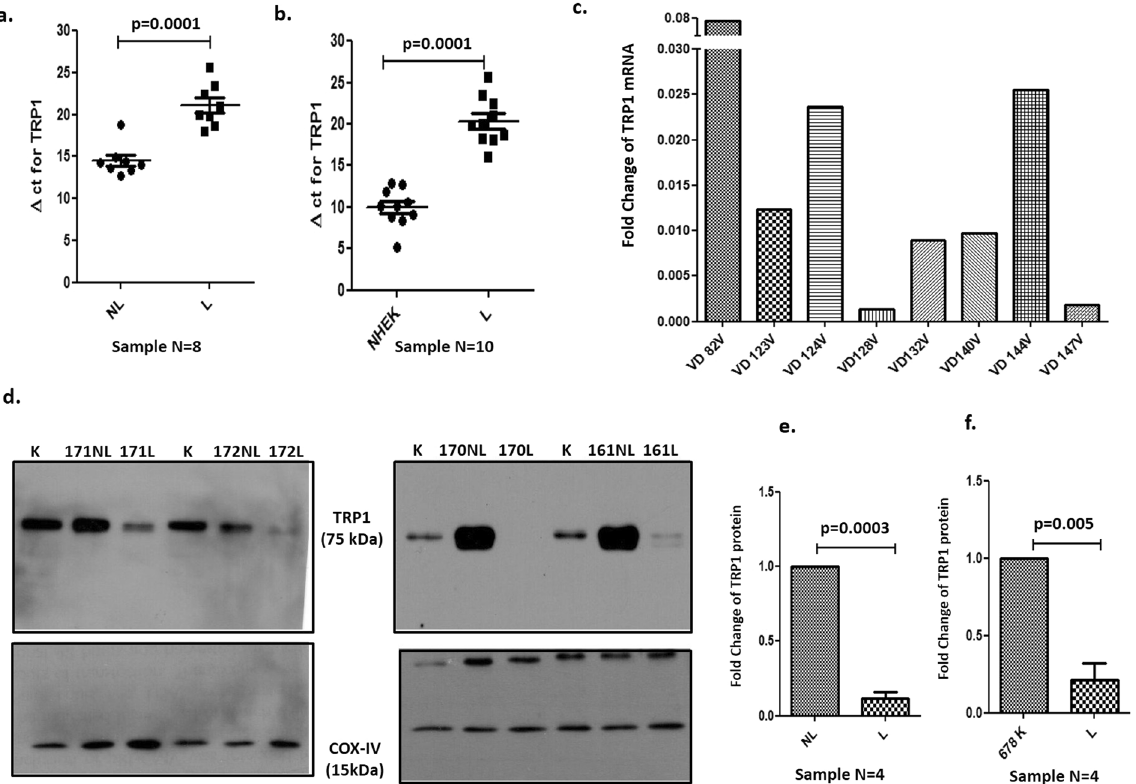
Figure 5. Expression of TRP1 in lesional (L), non-lesional (NL) epidermis and Normal human epidermal keratinocytes (NHEK). ( a ) Transcriptional expression of TRP1 shown as Δ CT in non-lesional and lesional epidermis from vitiligo patients. (n = 8) ( b ) Transcriptional expression of TRP1 shown as Δ CT in NHEK (n = 10) and lesional epidermis (n = 10) from vitiligo patients, ( c ) Downregulation of TRP1 expression in terms of fold change in lesional epidermis compared with non-lesional epidermis in 8 Vitiligo patients samples (VD). ( d ) Western blot for expression of TRP1 in four samples of non-lesional vs. lesional epidermis and normal human epidermal keratinocytes (678 K) at protein level showing lower expression in lesional epidermis. Full gel pictures are shown in Supplementary Fig. 14. ( e ) Densitometric analysis for expression of TRP1 in Non-lesional vs. Lesional epidermis normalized with endogenous control COX-IV. ( f ) Densitometric analysis for expression of TRP1 in Keratinocytes (678 K) vs. Lesional epidermis. All the bars showing reduced expression are depicted as mean ±